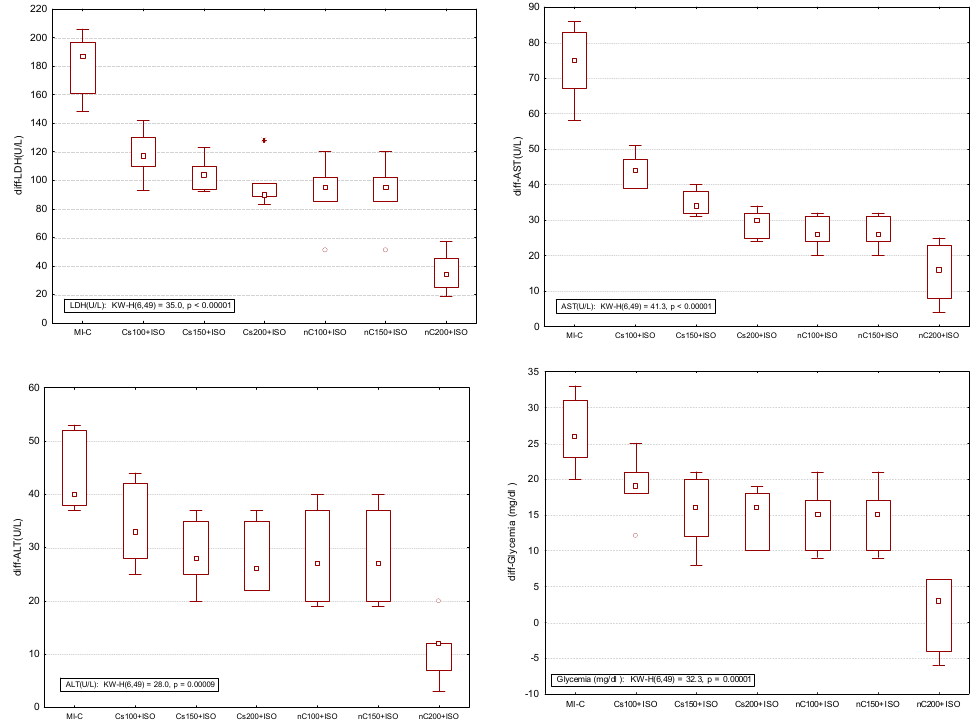
Figure 9. Differences relative to the control (no myocardial infarction, C group) of serum analysis represented by lactate dehydrogenase (LDH), aspartate transaminase (AST), alanine transaminase (ALT), and glycaemia. * extreme value; outlier. (cid:35)